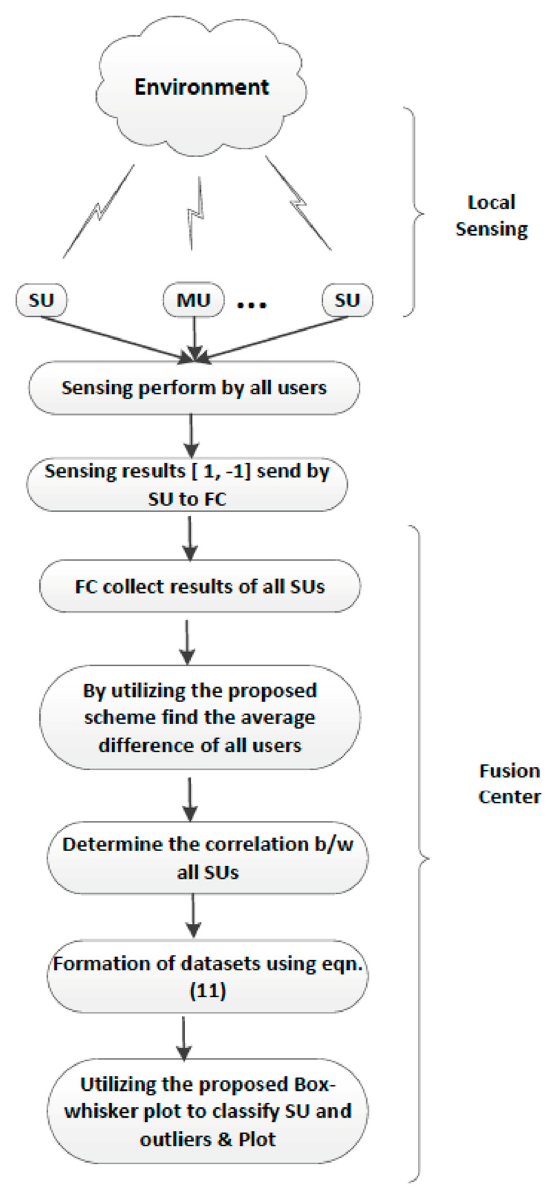
Figure 2. Flow chart of the proposed scheme.